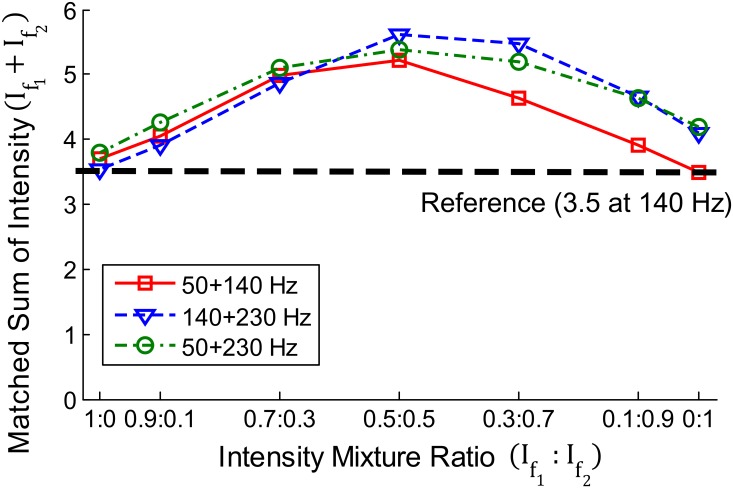
Averaged results of intensity matching in Experiment I.The arithmetic sum of the perceived intensities for the superimposed components are represented. The dotted horizontal line represents the reference perceived intensity.